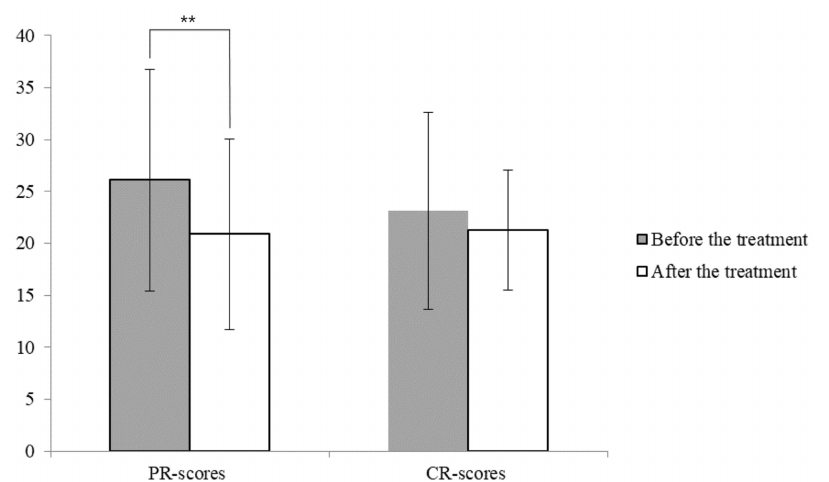
Figure 2. The relative periodontitis and caries risk scores after 4 weeks of dexamethasone treatment. (**: Wilcoxon signed-rank test significance level at 0.01; CR-score, relative caries risk score; PR-score, relative periodontitis risk